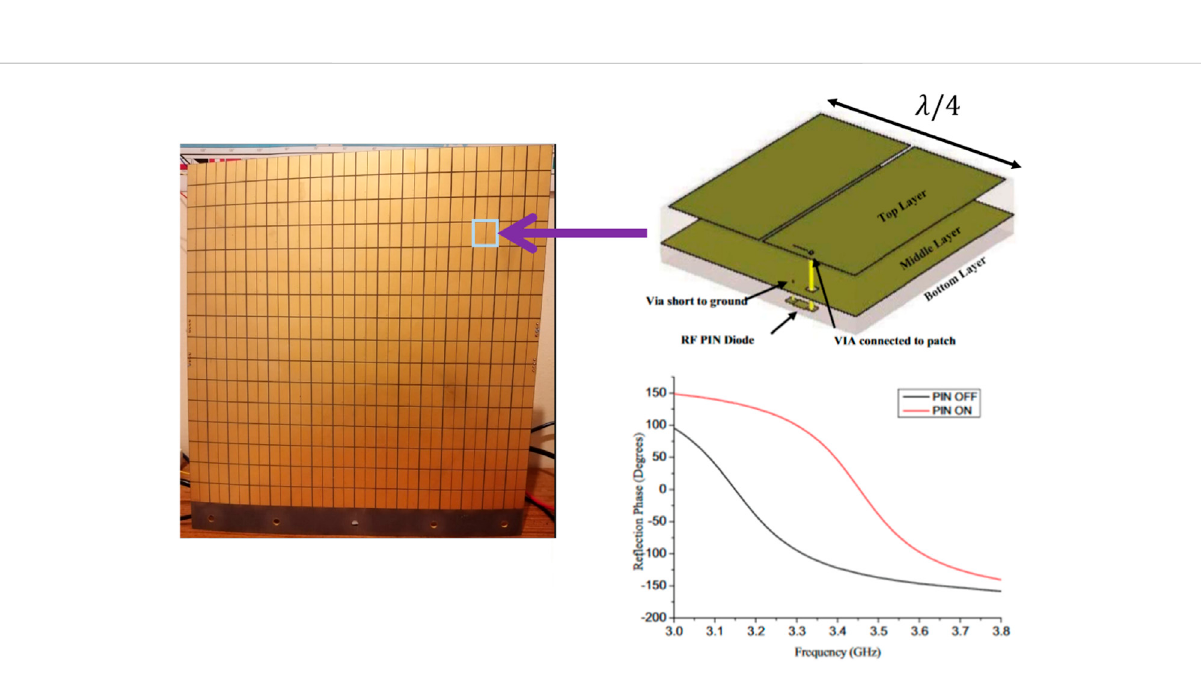
FIGURE 16 Overall proposed view of the unit cell with the diode (Kazim et al., 2020).